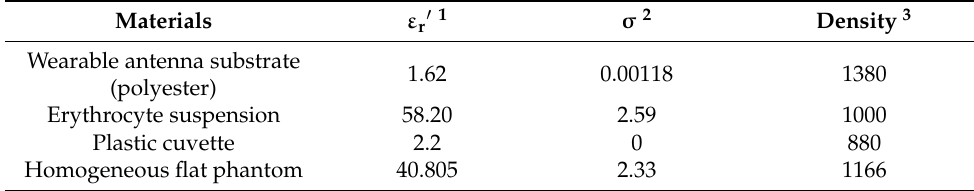
Table 1. Electromagnetic properties of the materials involved in the wearable antenna geometry erythrocyte suspension, plastic box, and flat